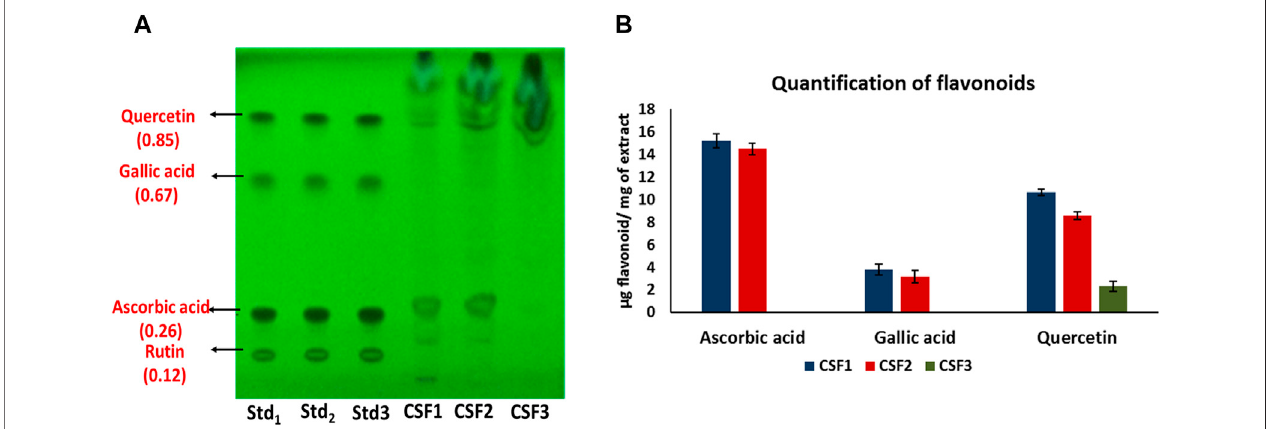
FIGURE 4 | HPTLC chromatogram at 254 nm con fi rms the presence of ascorbic acid, gallic acid and quercetin in CSF1 and CSF2 extracts, and only quercetin in CSF3 extract. Respective retardation factor values are written in parentheses (A) . Quantities detected from densitometric scanning are also given (B) . Lanes labelled Std 1 , Std 2 and Std 3 contain 0.75, 0.875 and 1 µg of each standard fl avonoid. Values for quanti fi cation are represented as mean ± SD ( n (cid:1) 3).